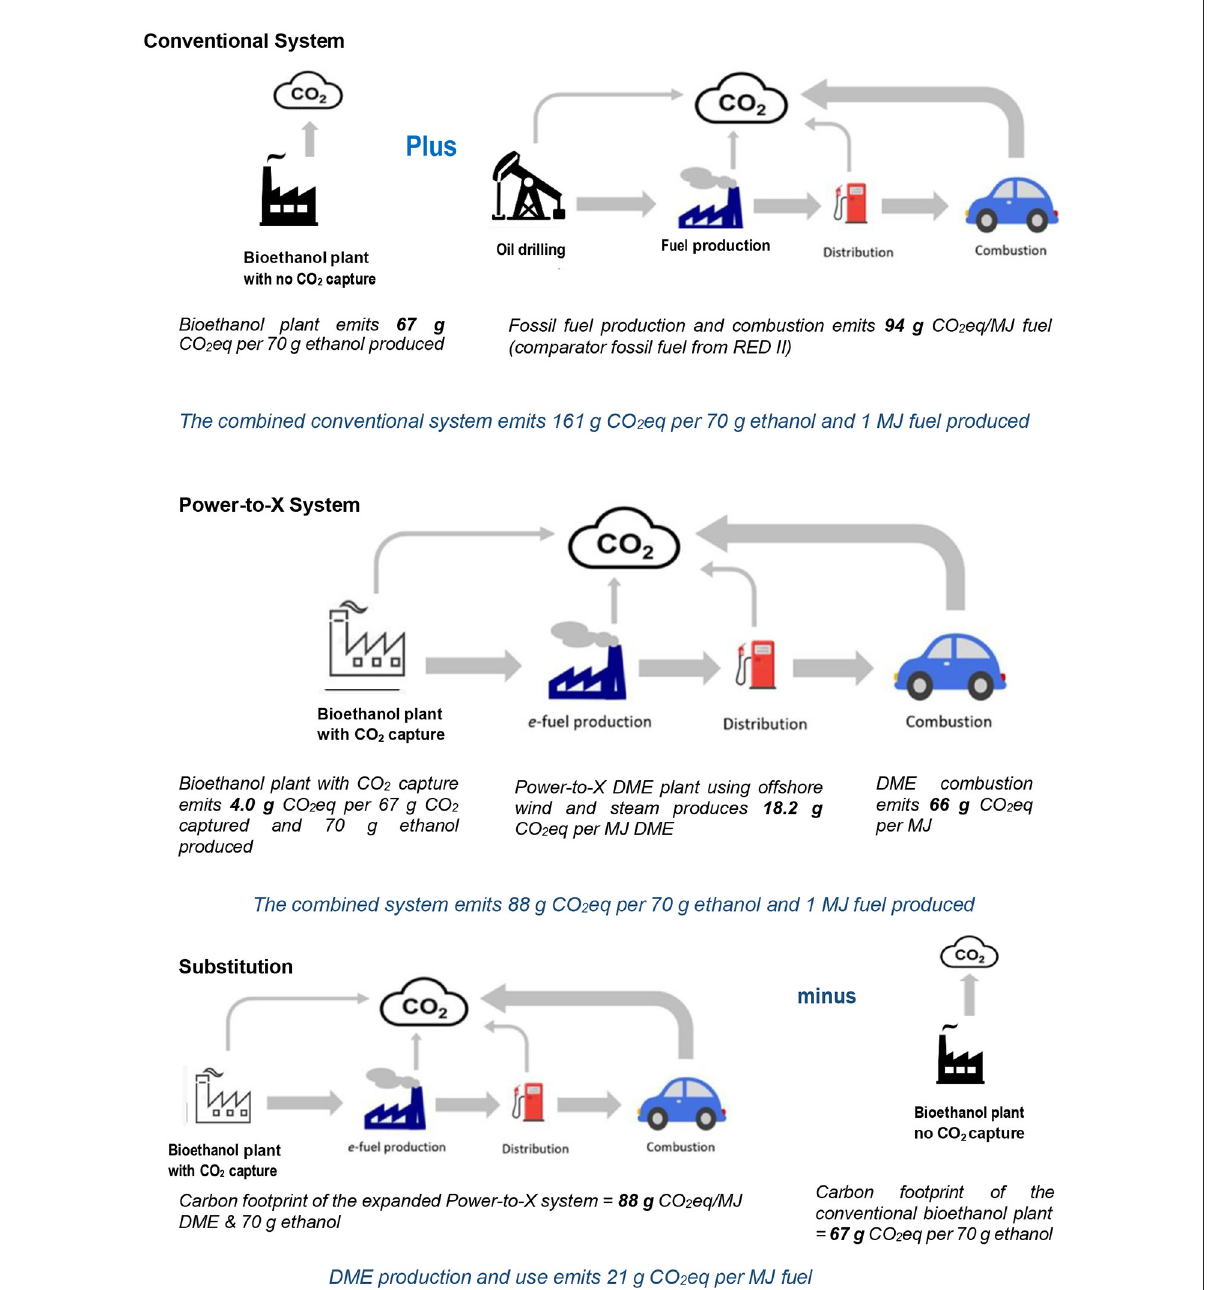
FIGURE4 Carbon-flow in the conventional system compared to the Power-to-X system using offshore wind power and heat derived from steam from the chemicals industry. Substitution is used to subtract the emissions from the bioethanol plant, leaving just the emissions from DME production and